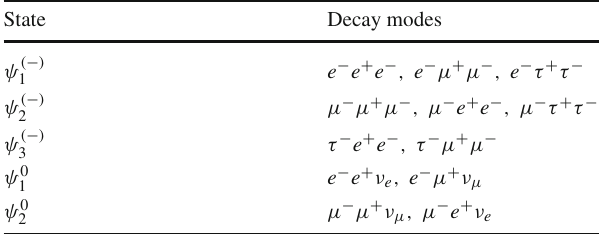
Table 2 Parameters used in the event generation, detector simulation ( − ) ψ ( − ) and the reconstruction algorithm i i